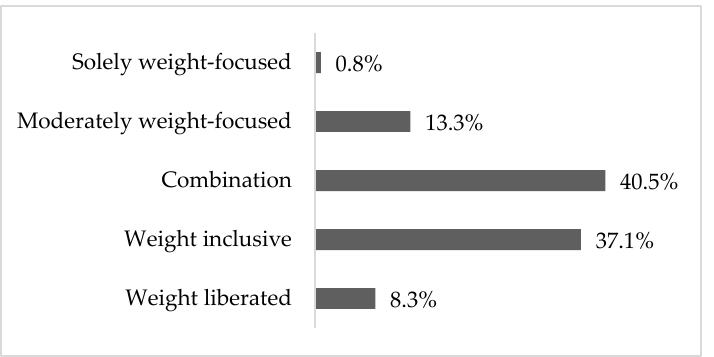
Figure 1. The proportion of Registered Dietitians who practice using the following approaches when working with higher-weight clients. Table 3. The proportion of dietitians who practiced according to each practice approach and the descriptive labels used to characterize each practice approach.